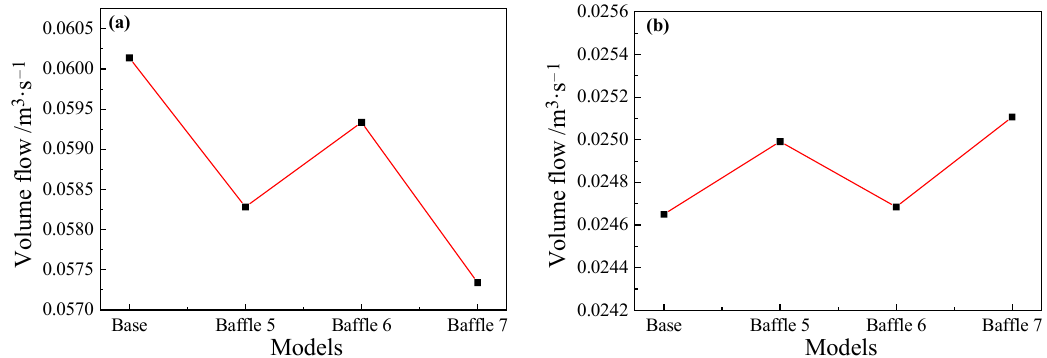
Figure 24. Volume flow at positions: ( a ) upstream (4.5 m); and ( b ) downstream (5.2 m) of the baffle for main troughs with different heights.